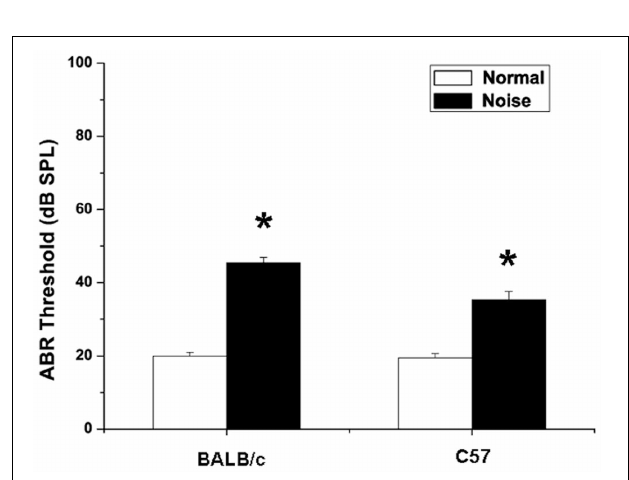
FIGURE 4 | Changes in auditory brainstem response of BALB/c mice and C57 mice after noise exposure. Normal group: mice received no treatment and placed in the noise booth but not exposed to noise. Noise group: mice were exposed to 4-kHz octave-band noise at 110dB SPL for 8h per day for 14 consecutive day. ∗ P < 0 .